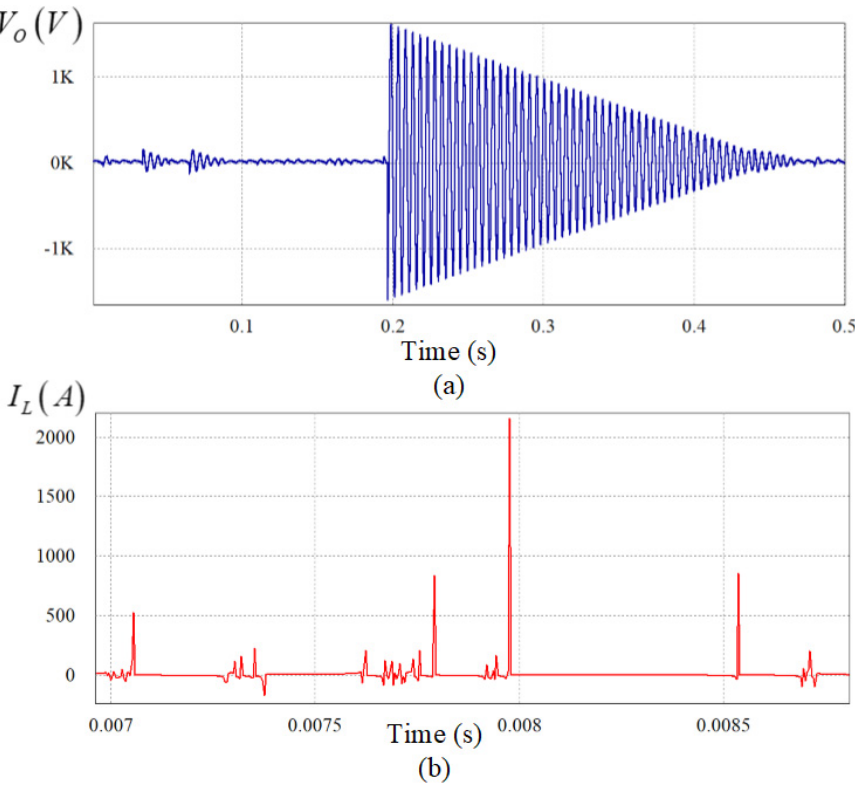
Figure 5. Behavior of the output current and voltage of a buck converter supplying a CPL ( v in = 28 V, C = 220 uF, L = 20 W, P CPL = 20 W, and d = 0.5). ( a ) output voltage, ( b ) output current.